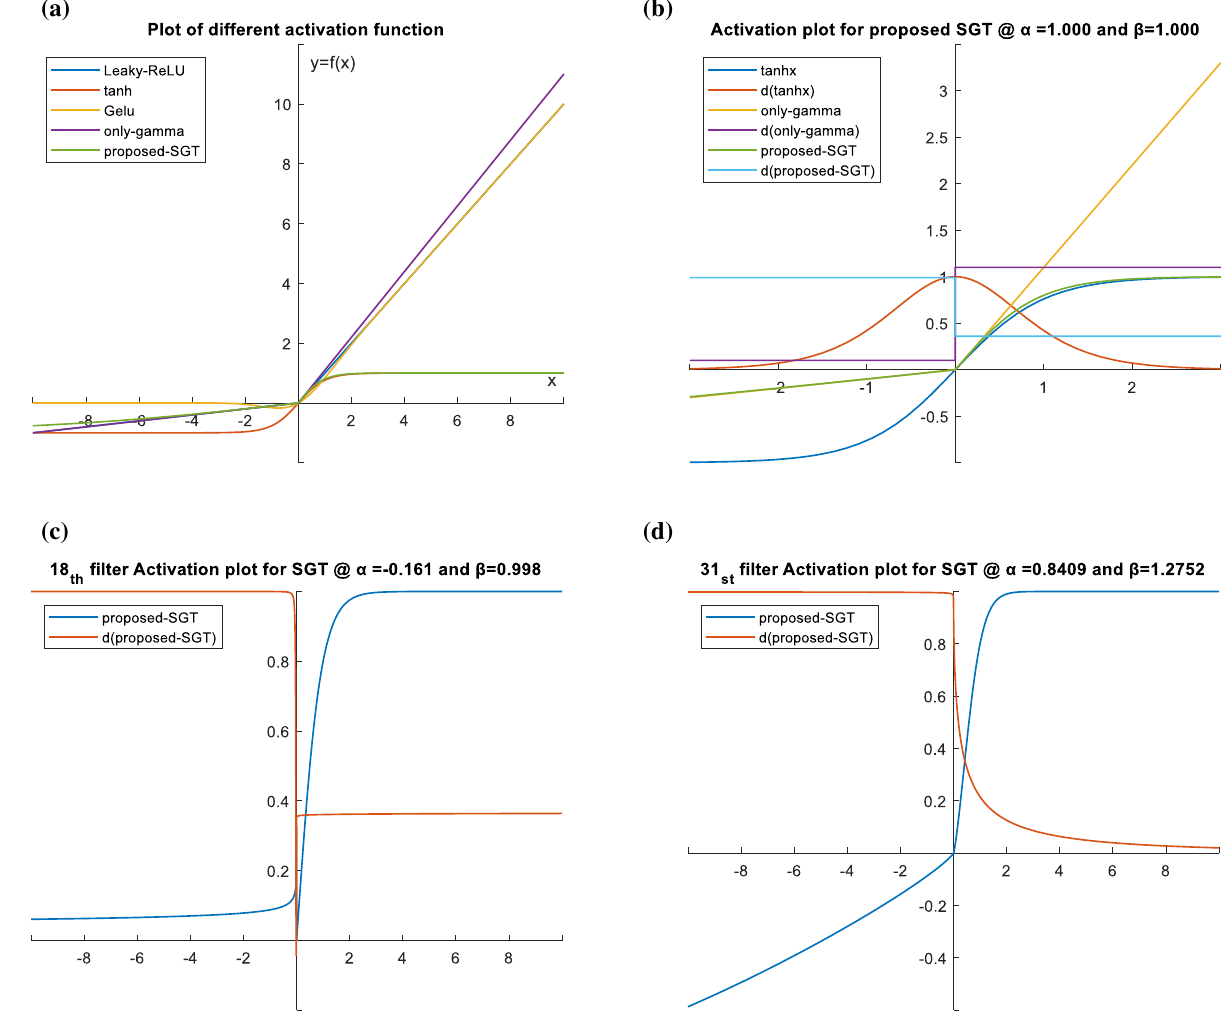
Figure 2. ( a ) Activation function plot for input x and f(x) along with other popular activation functions near x = 0. Please see "Appendix" for all the related equations. Please see Fig. 2_app in "Appendix" for all the related equations. ( b ) Activation (proposed-SGT) and first-order derivative (d(proposed-SGT)) plot with both exponents equal to 1 using a combination of gamma correction (‘only-gamma’) and hyperbolic tangent (‘tanh’) to illustrate the need for thresholding and squashing function. ( c ) Actual activation plot for the trained network in 18 th filter (out of 64) in layer 4. Here blue curve represents the SGT activation function whereas the red curve represents its first-order derivative. ( d ) Actual activation plot for the trained network in 31st filter (out of 64) in layer 4. Here blue curve represents the SGT activation function whereas the red curve represents its first-order